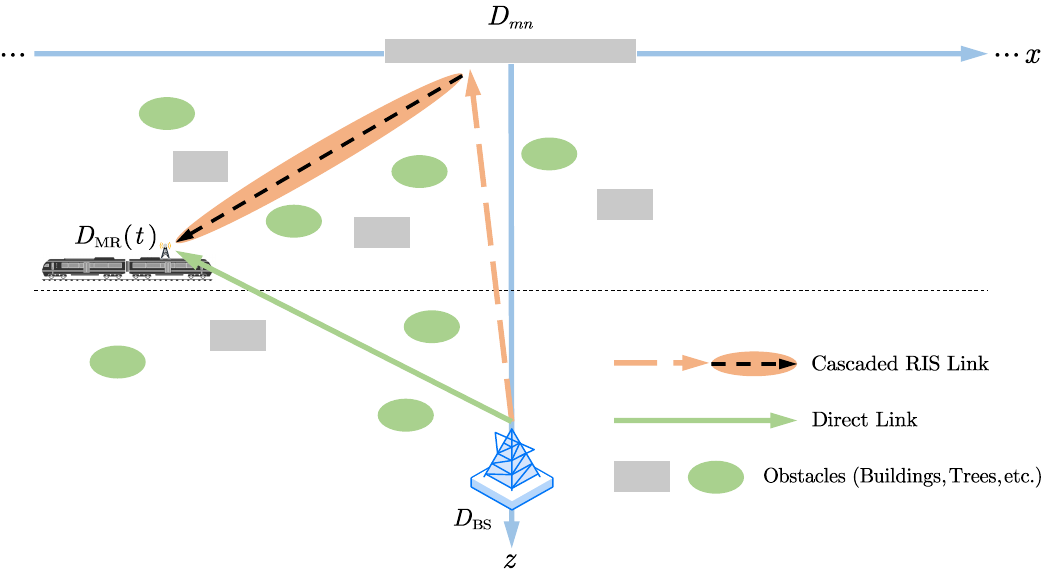
Figure 2. Top view of the proposed HSC system for numerical evaluations in this section.